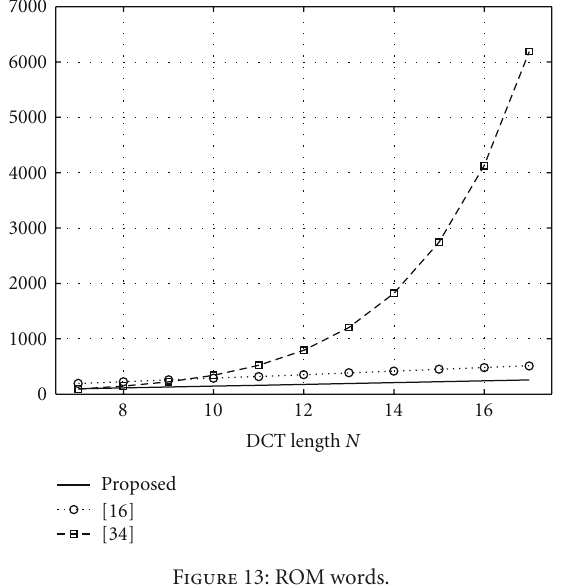
Figure 13: ROM words.